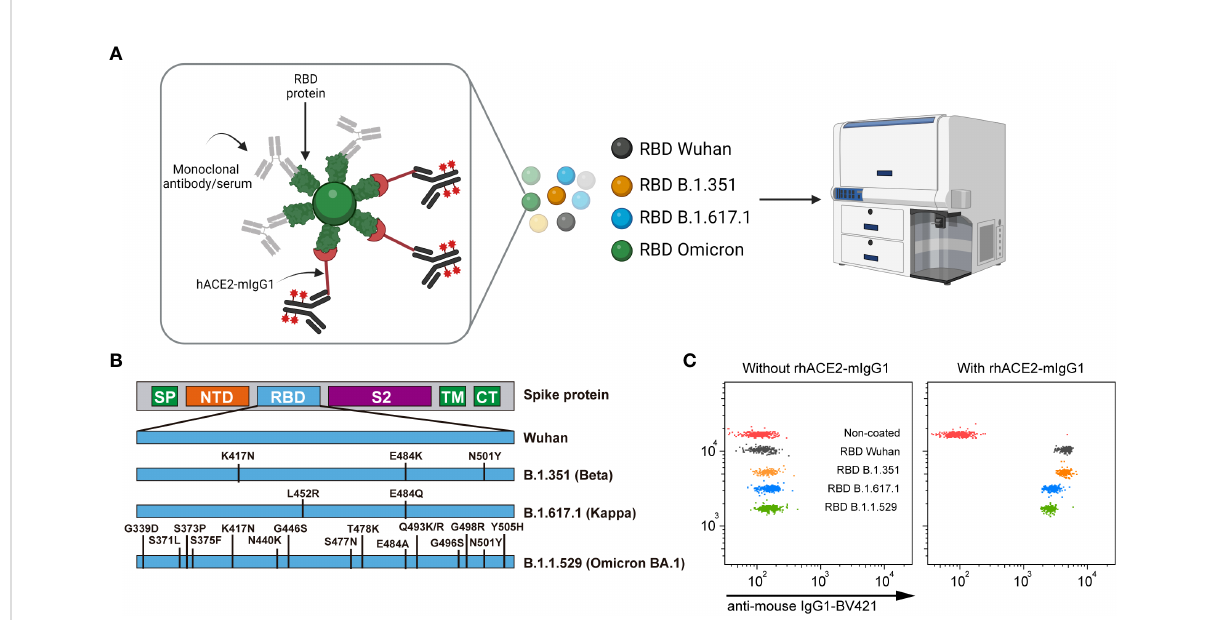
FIGURE 1 Overview of the SARS-CoV-2 neutralization multiplex assay by fl ow cytometry (nC19BA). (A) Beads with different fl uorescence intensities are coated with recombinant RBD proteins from the indicated variants and incubated with a given sample, followed by incubation with rhACE2- mIgG1. The binding of rhACE2 to RBD is detected with an anti-mouse IgG1 monoclonal antibody labelled with BV421 fl uorochrome. Schematic created using BioRender.com. (B) Schematic illustration showing the mutations present in the RBD variants included in this assay. (C) Representative dot plots showing rhACE2 binding to the indicated RBD variants. SP, Signal peptide; NTD, N-terminal domain; RBD, Receptor binding domain; S2, S2 subunit; TM, transmembrane domain; CT, cytoplasmic tail